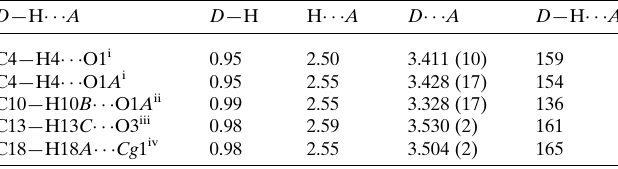
Table 1 Hydrogen-bond geometry (A˚ , (cid:3) ). Cg 1 is the centroid of the benzene ring.